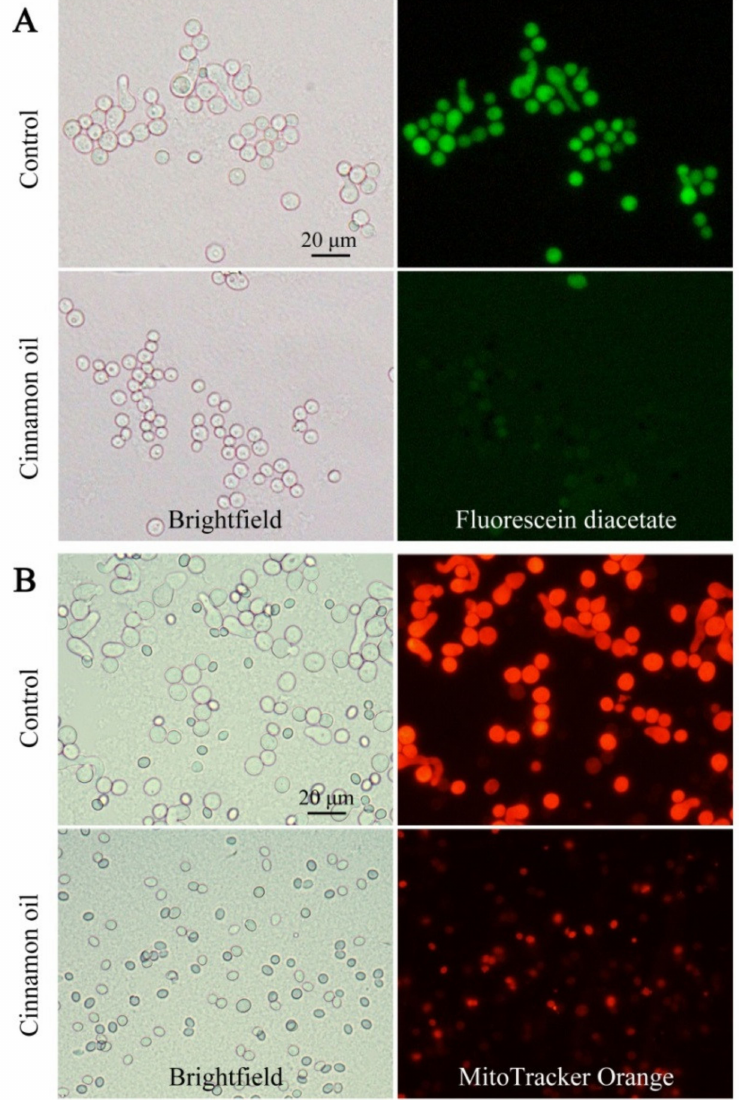
Figure 2. Microscopic observations of spores with fluorescein diacetate ( A ) and MitoTracker Orange staining ( B ) after 6 h of incubation under 0.25 mg L − 1 cinnamon oil